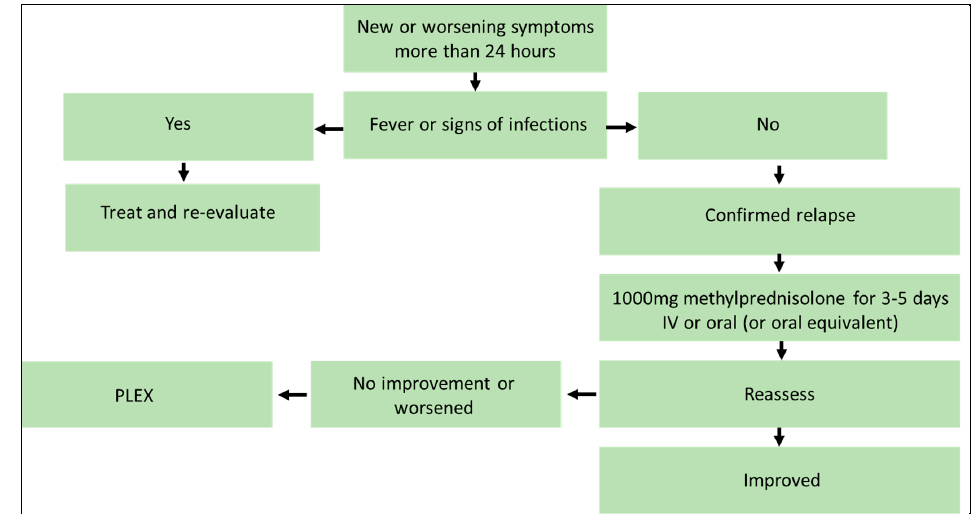
Figure 2. Algorithm for management of acute relapse. Figure was created by authors. No permission needed.